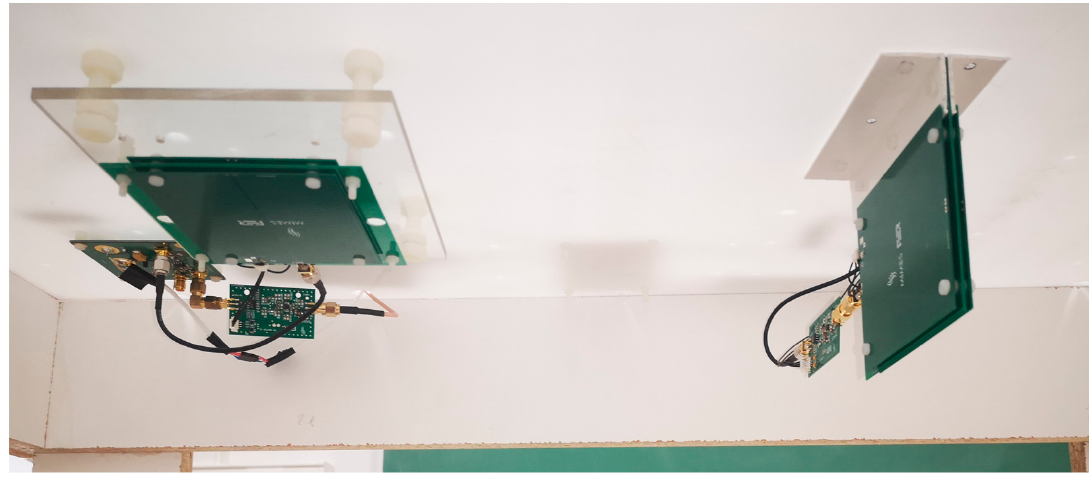
Figure 2. The photograph of the sensor: transmitter ( left ) and receiver ( right ).